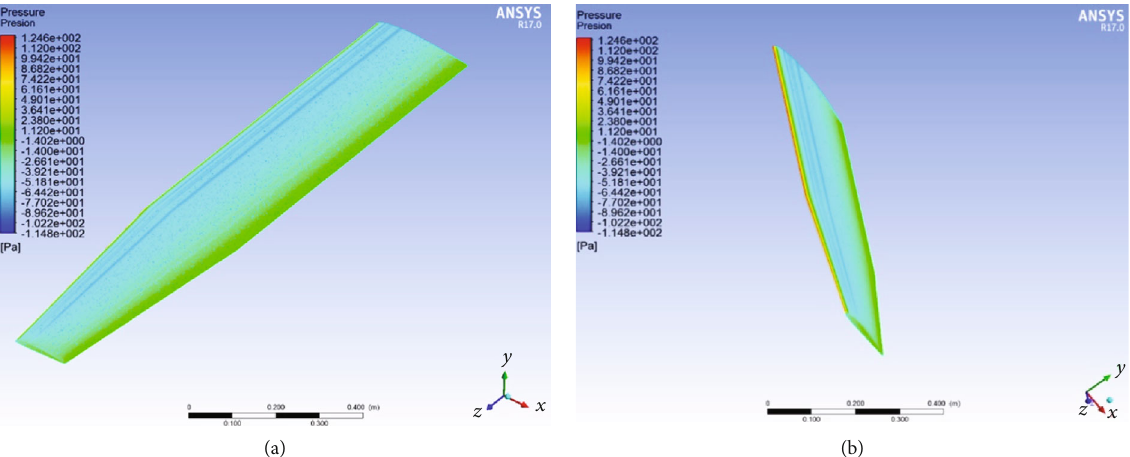
Figure 14: (a) Pressure on the main wing. (b) Pressure on the leading edge of the wing at an angle of attack of 12deg.